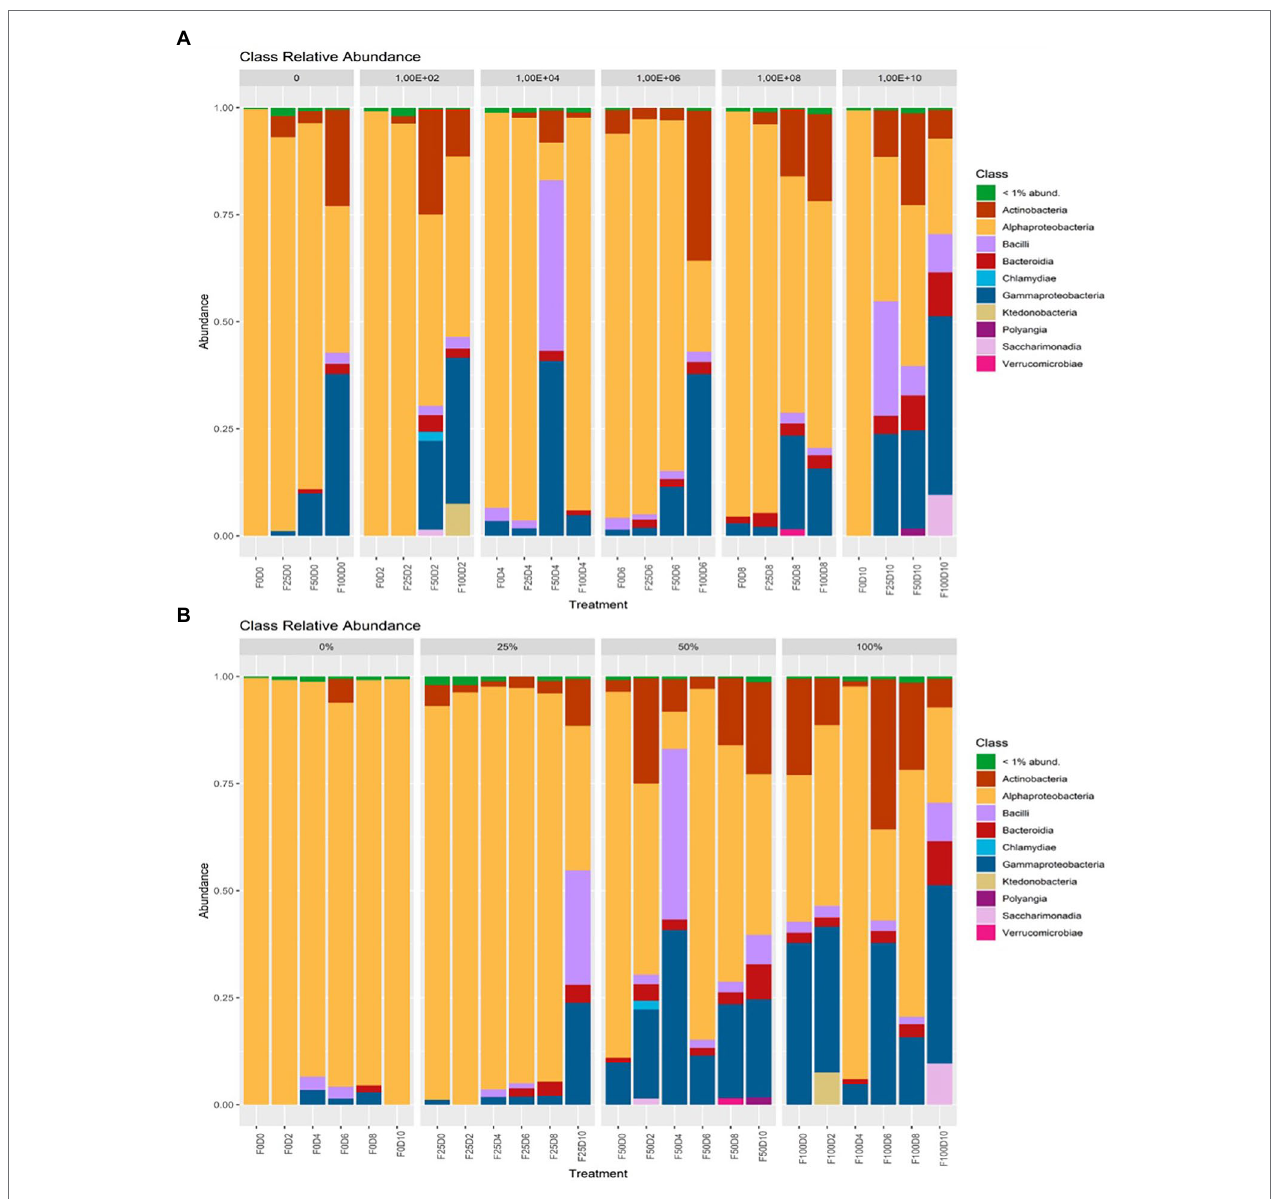
FIGURE 5 | Taxonomic affiliation at the phylum level regarding inoculation (A) and fertilization (B)